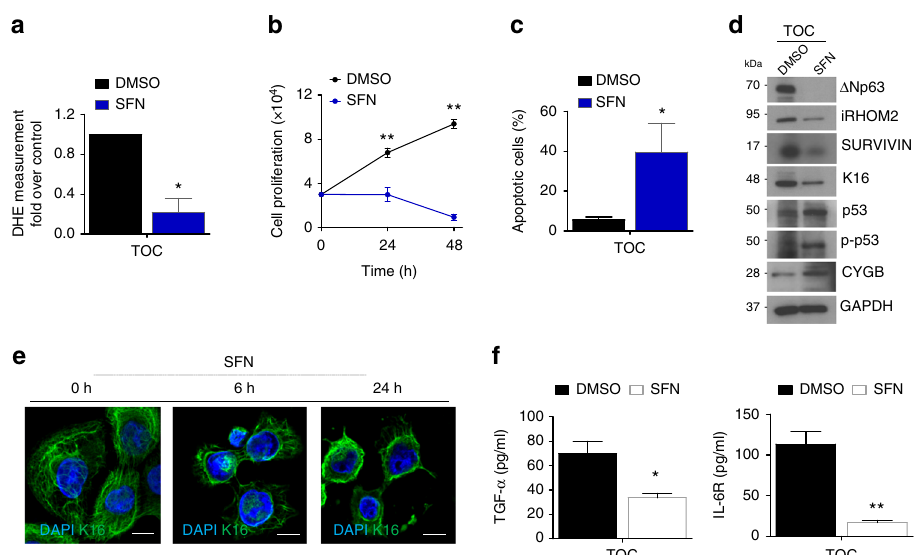
Fig. 6 SFN represses iRHOM2 – p63 pathway in TOC. a Quanti fi cation of DHE staining by fl ow cytometry in TOC keratinocytes treated with dimethyl sulfoxide (DMSO; the vehicle control) and sulforaphane (SFN) (10 µ M) for 24 h. b Growth curves of TOC cells cultured with SFN (10 µ M) or DMSO for 0, 24 and 48 h post treatment. Data are expressed as mean ± SEM. c Percentage of apoptotic cells was quanti fi ed by using fl ow cytometry analysis of annexin-V-positive populations detected after 24 h incubation with SFN (10 µ M) or DMSO, in TOC cells. Bars represent mean values with SEM of four experiments. d Immunoblotting of lysates from TOC keratinocytes treated with SFN (10 µ M) or DMSO for 24 h and analysed for Δ Np63, iRHOM2, SURVIVIN, K16, p53, phopho-p53 and CYGB expression. GAPDH is used as a loading control. e Immuno fl uorescence staining of K16 in TOC cells after 0, 6 and 24 h of SFN incubation. Scale bar: 20 µ m. f ELISA for TGF α and IL-6R with the supernatants of TOC cells treated with SFN (10 µ M) or DMSO for 24 h. All data are expressed as mean and SEM of three experiments. Statistical analysis was performed by Student ’ s two-tailed t -test (* p < 0.05 and ** p <